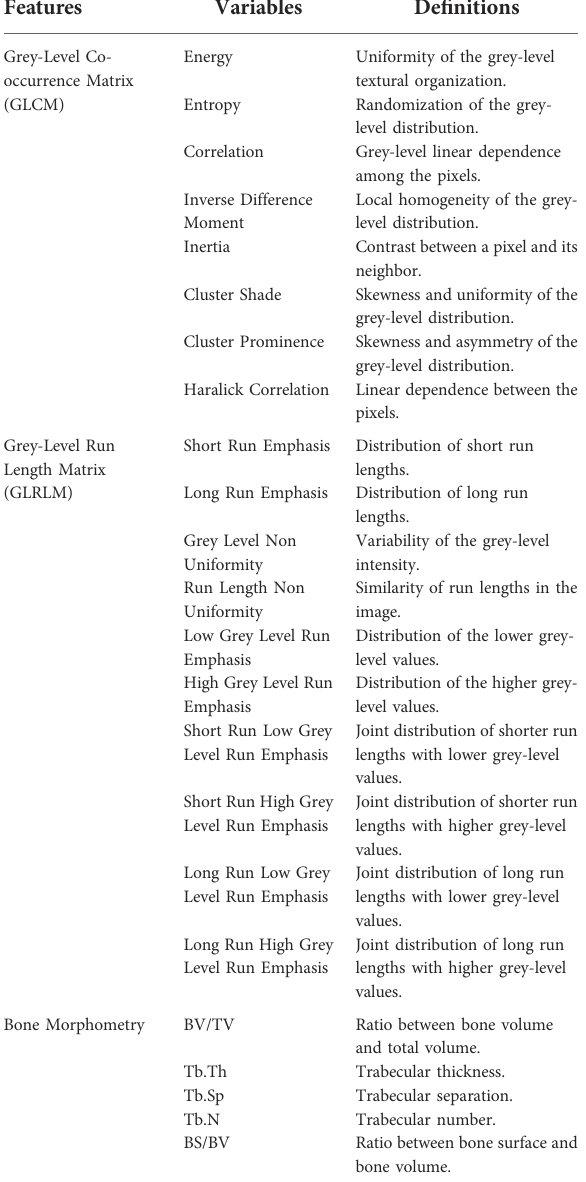
TABLE 1 Description of the variables for radiomic and bone morphometry features.